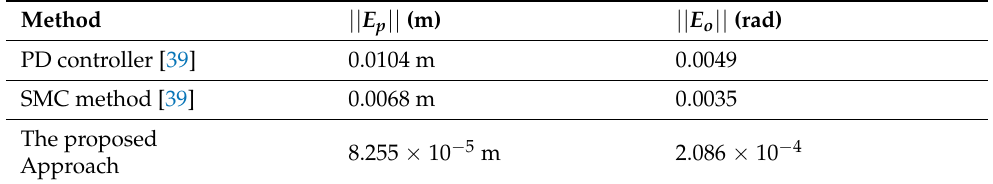
Figure 9. 3D position behavior of UR5 using the proposed controller in the x-y plane. Table 3. Tacking position and orientation errors in the case of the second